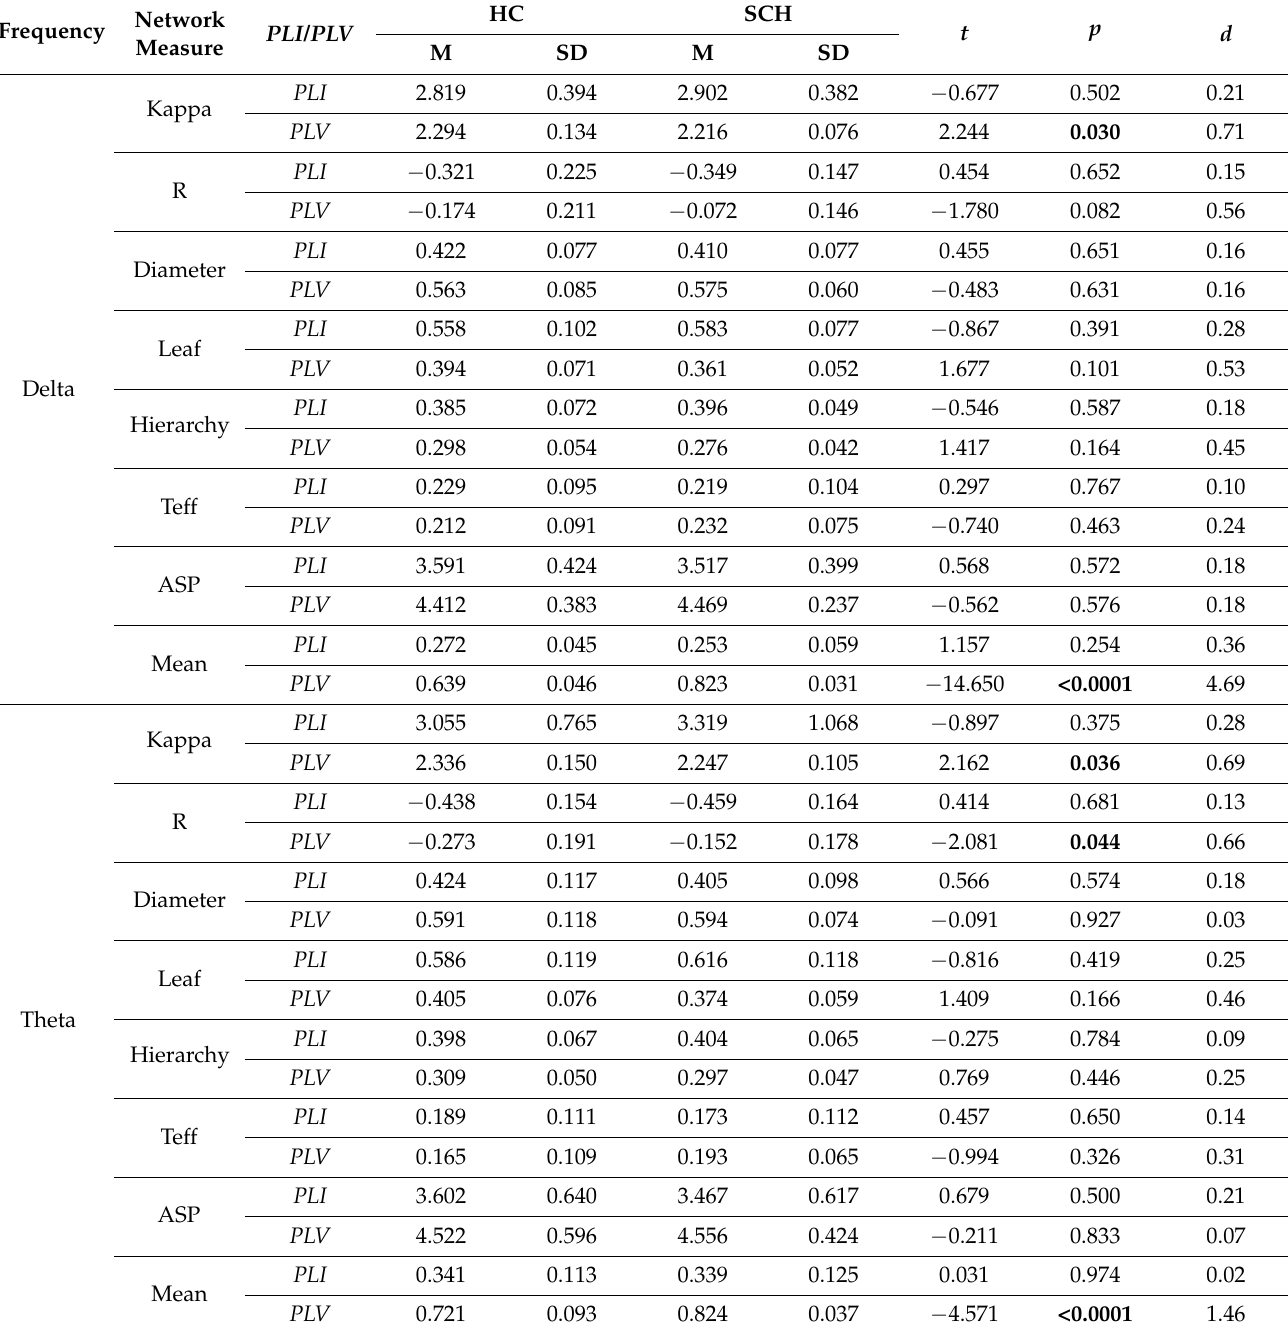
Table A1. Comparisons of the studied groups regarding MST-related network measures based on PLI or PLV indexes of functional connectivity at all included